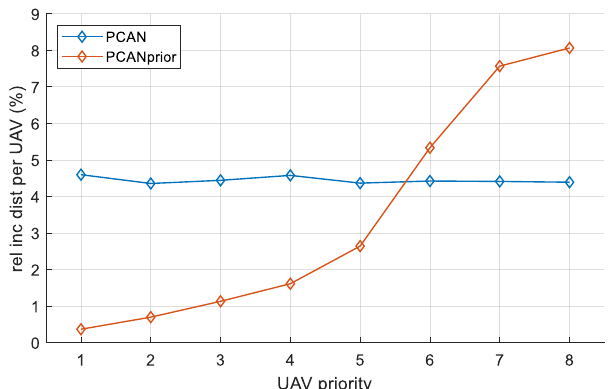
Figure 6. Relative increment in distance, compared with the direct algorithm, by UAV priority classes.